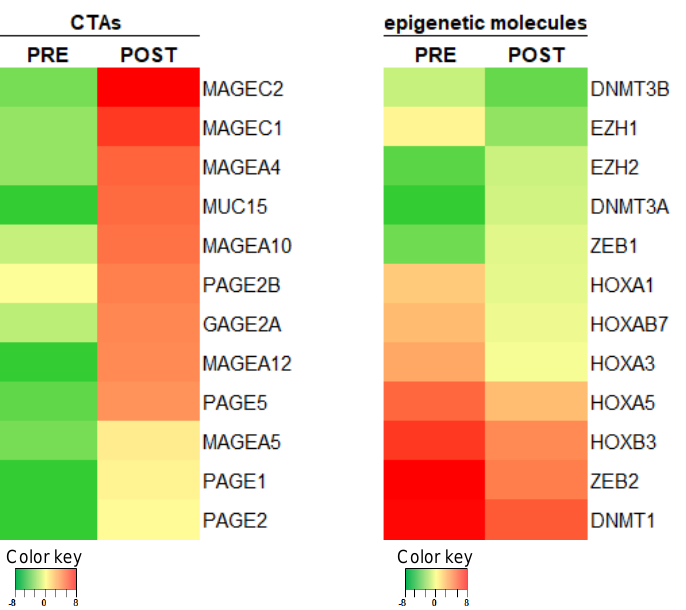
Figure 2. Genes modulated by imatinib in FS-DFSP. Heatmaps showing the expression levels of selected genes encoding cancer testing antigens (CTAs) or epigenetic molecules determined by RNAseq analysis of FS-DFSP pre- and post-imatinib